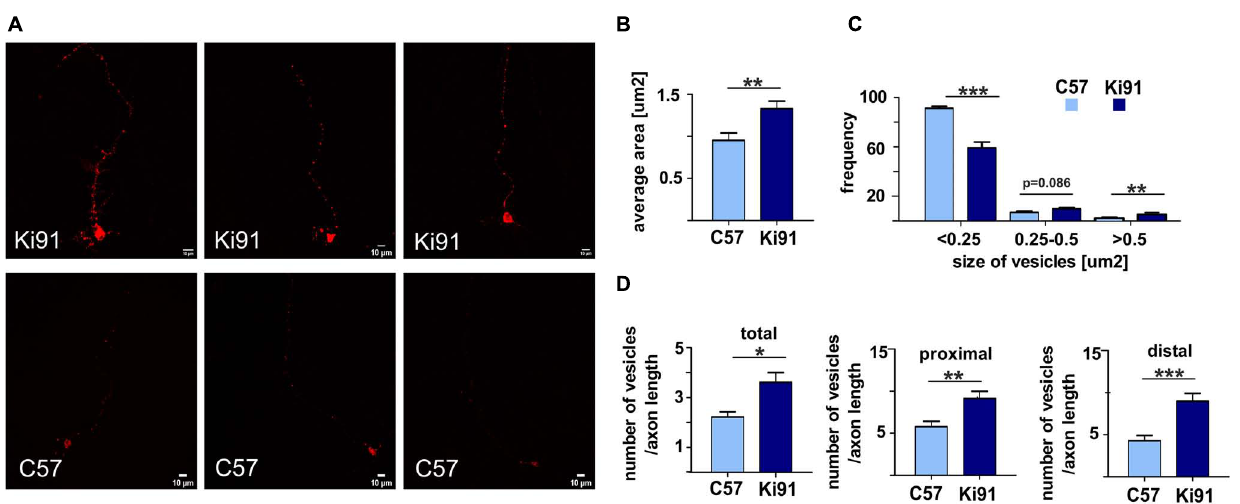
FIGURE 8 | Accumulation and enlargement of vesicles in Ki91 SCA3/MJD P5 cerebellar neurons. To investigate if the consensus vesicular and transport process identified by various types of proteomics in Ki91 impacts vesicle appearance and number, we transfected the primary cerebellar neurons (DIV8-9) with RFP-labeled Rab7. The Rab7 was selected as a useful vesicle tag since it is often recruited to several types of vesicles, including late endosomes and lysosomes (red). Representative images show fluorescently tagged vesicles in cerebellar neurons from Ki91 mice (upper panel) and WT neurons (lower panel) (A) . The sizes and the number of tagged vesicles were quantified using ImageJ. The average area of fluorescently tagged vesicles was 1.33 µ m 2 ( n = 45) for Ki91, 0.95 µ m 2 ( n = 34) for WT ( p < 0.01; two-sample t -test) (B) . The size distribution of tagged vesicles in Ki91 cerebellar neurons showed a shift from smaller to larger sizes in comparison to WT ( p < 0.001; two-sample t -test) (C) . The number of vesicles per axon length was higher in Ki91 neurons, also measured separately for both proximal and distal parts (defined as 1/8 of the axon length starting either from the axon hillock or axon tip) (D) . The measurements were from five independent experiments, with 5–10 cells analyzed each time. Scale bars: 10 µ m. Two-sample t -test (* p < 0.05, ** p < 0.01, *** p < 0.001), error bars: SEM.